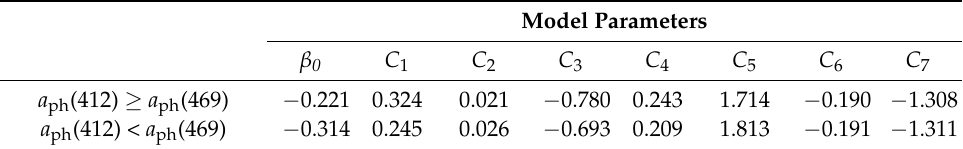
derived from estimated (cid:1853) (cid:2926)(cid:2918)(cid:2929)(cid:2930)(cid:2914) ( λ ) through QAA-v6 using in situ PRR data. Solid line represents Table 4. Model parameters ( β 0 and C j in Equation (12)) for CSD slope estimation.